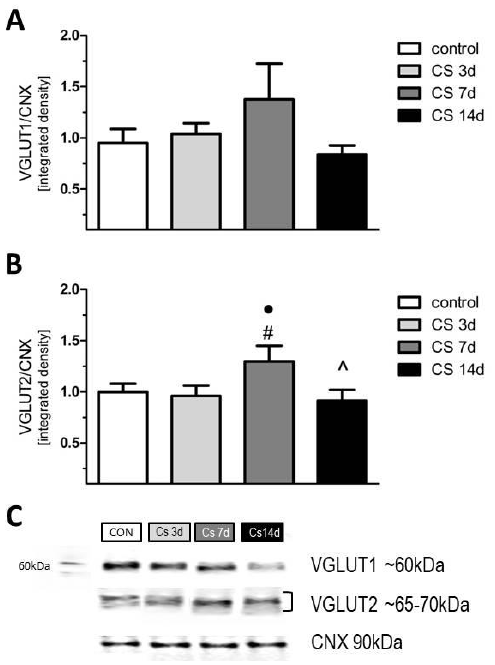
Figure 8. The influence of crowding stress and its duration on the expression of glutamate trans- porters in the rat FC. Expression of VGLUT1 ( A ), VGLUT2 ( B ). ( C ) Representative immunoblots that illustrate VGLUTs expression in the FC after crowding stress (CS). Data were calculated as percentages of controls and are expressed as means ± SEM (control: n = 9; CS 3d: n = 5; CS 7d: n = 5; CS 14d: n = 5) ● 1> p > 0.05 vs. control (LSD test); # p < 0.05 vs. SC 3days; ^ p < 0.05 vs. CS-7days, (LSD test).